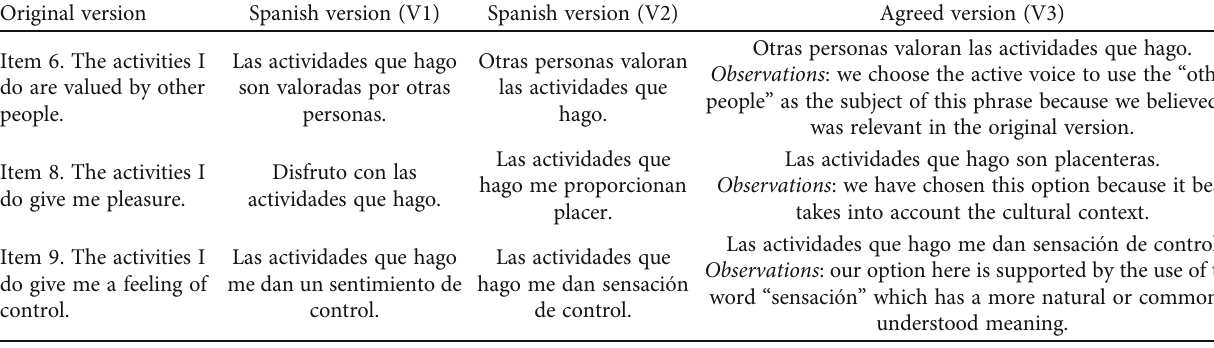
Table 1: Examples of the forward translation of EMAS from English to Spanish.